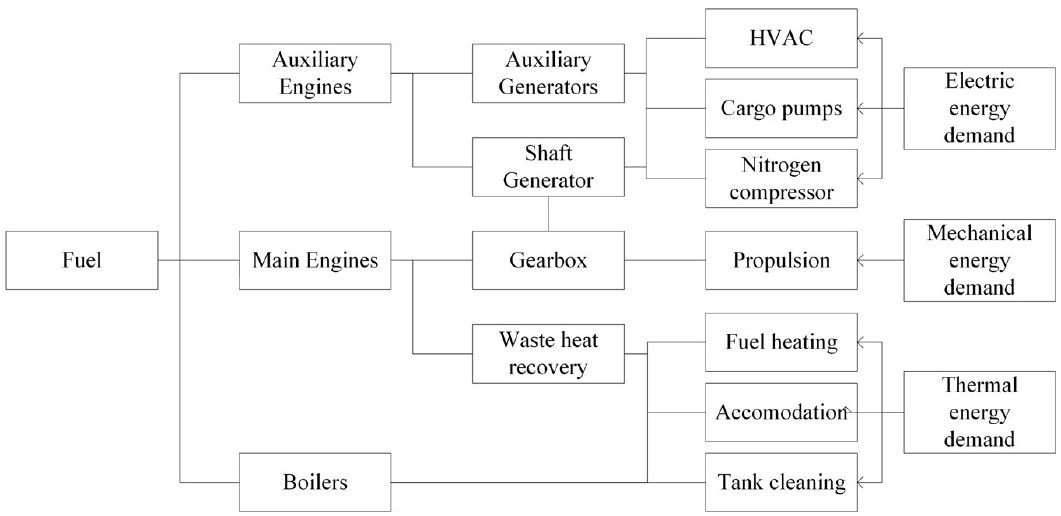
Figure 1. A simplified energy system of a chemical tanker.